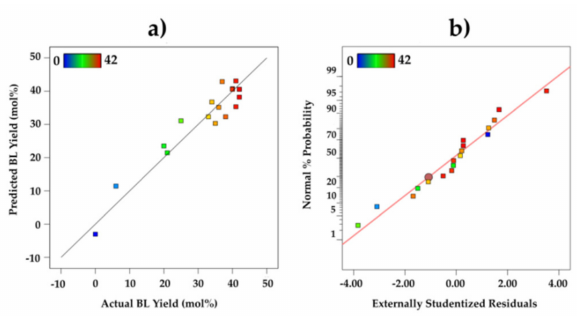
Figure 7. ( a ) Predicted versus actual plot, and ( b ) normal plot of residues.